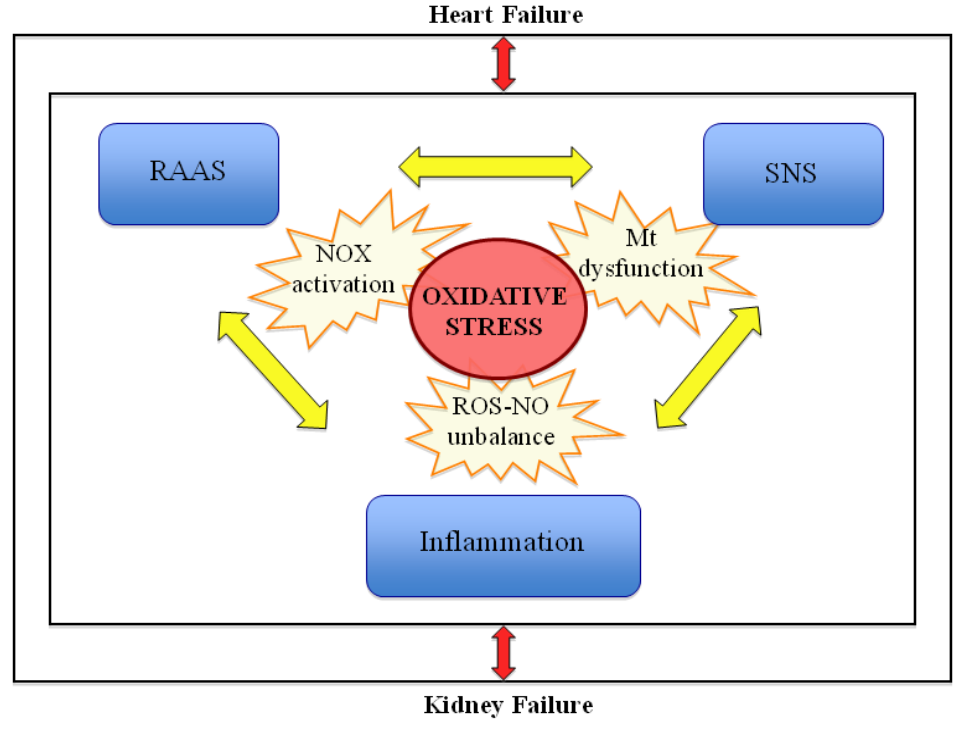
Figure 3. Mechanisms involved in the pathogenesis of chronic cardiorenal syndrome. When either the heart or kidneys fails, a vicious cycle develops: the renin-angiotensin-aldosterone system, the sympathetic nervous system and the inflammatory process interact and synergize to lead to NADPH oxidase activation, mitochondrial dysfunction and NO-ROS unbalance, ultimately causing increased oxidative stress and further impairment of organ function. Legend: NOX = NADPH oxidase; RAAS = renin-angiotensin-aldosterone system; SNS = sympathetic nervous system; ROS = Reactive oxigen species; NO = nitric oxide; Mt =